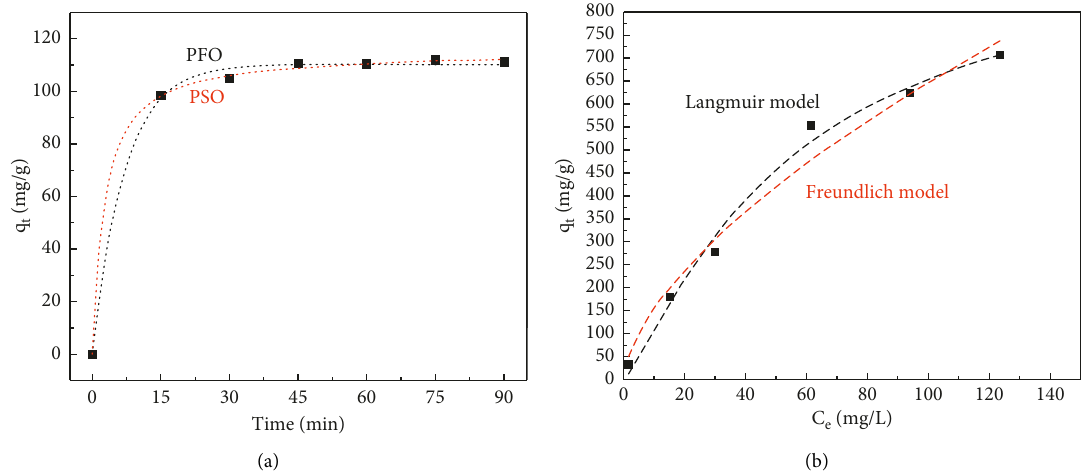
Figure 8: (a)Adsorption kinetics of CR onto GluP fitted by PFO and PSO models (0.25 g · L − 1 adsorbent, 30mg · L − 1 dye, pH � 7, 25 ° C). (b) Adsorption isotherms of CR onto GluP fitted by Langmuir and Freundlich models (0.25 g · L − 1 adsorbent, pH � 7, 25 ° C).